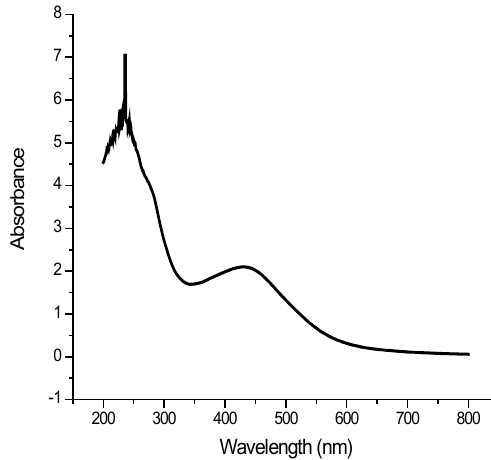
Fig. 2(b): UV-VIS Spectra of GS-RAgNPS at 3mM AgNO 3